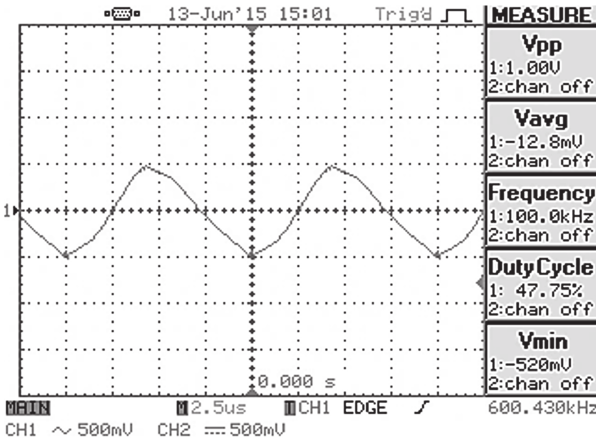
Figure 9: Plot of ripple voltage versus time at 100kHz and 𝐷 = 40%.